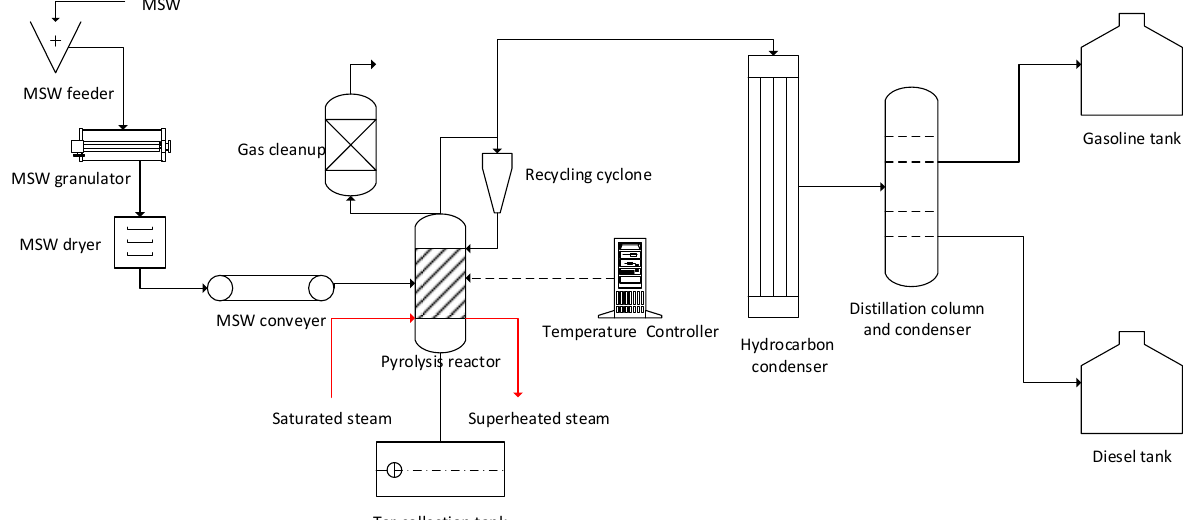
Figure 5. Process flow diagram of solid waste pyrolysis